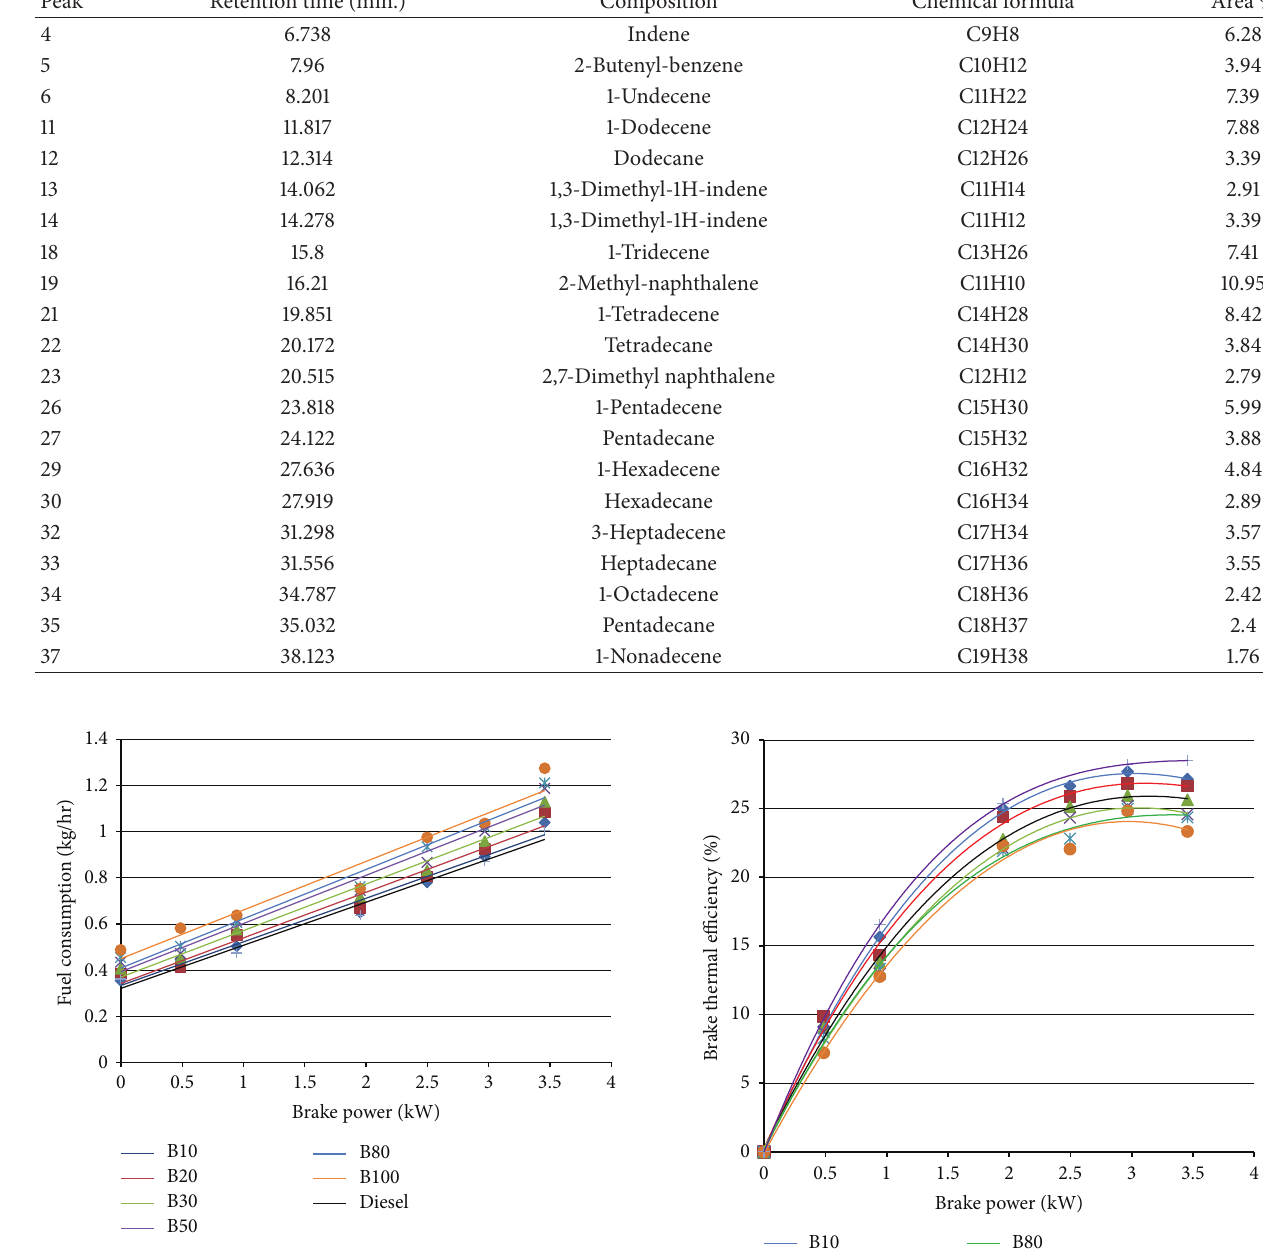
Figure 4: Fuel consumption versus brake power.